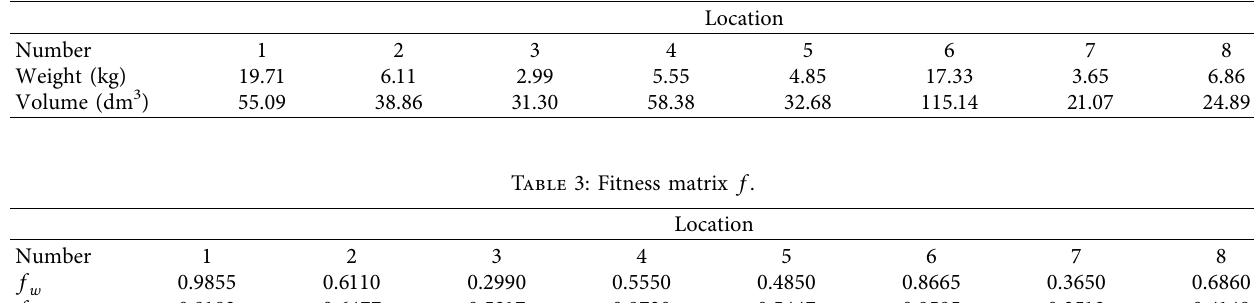
Table 2: The total amount of goods of each pickup location.